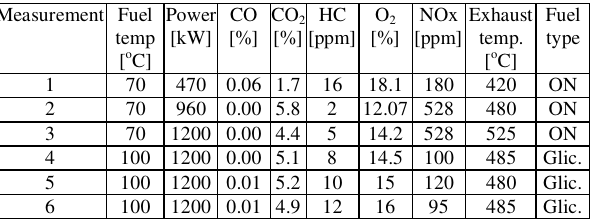
Table 2. Selected results of the glycerine burning tests in the ZS engine [6] Measurement Fuel